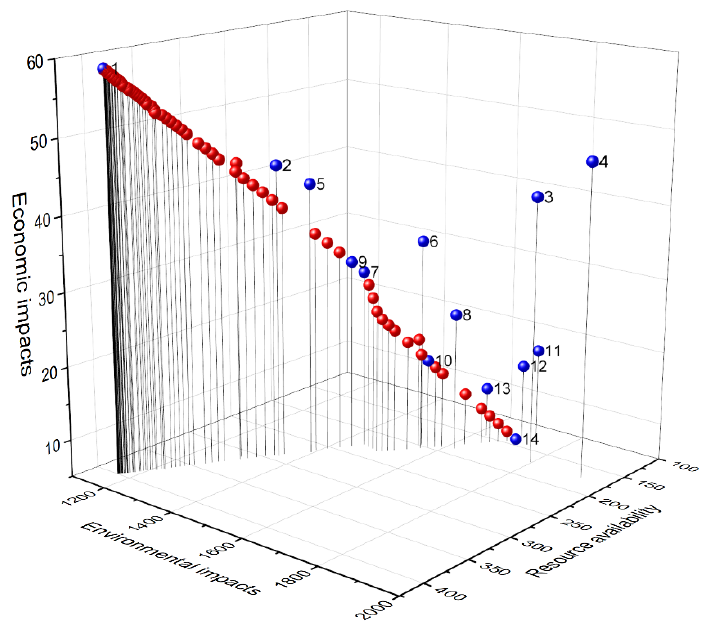
Figure 1. Optimal mixes in Belgium.